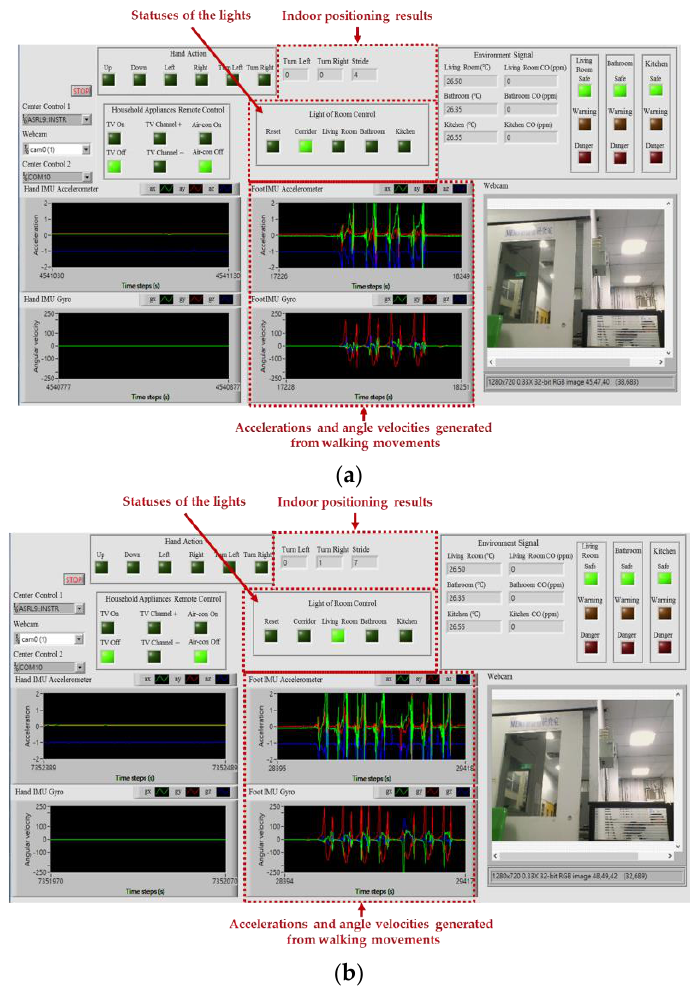
Figure 18. Accelerations and angular velocities generated from walking movements, indoor positioning results, and statuses of the lights shown on the intelligent monitoring interface. ( a ) The resident walked in the corridor, and the lights in the corridor were turned on and the others in the other indoor environment were turned off; ( b ) The resident left the corridor and walked into the living room, and the light in the living room was turned on and the others in the other indoor environment were turned off.